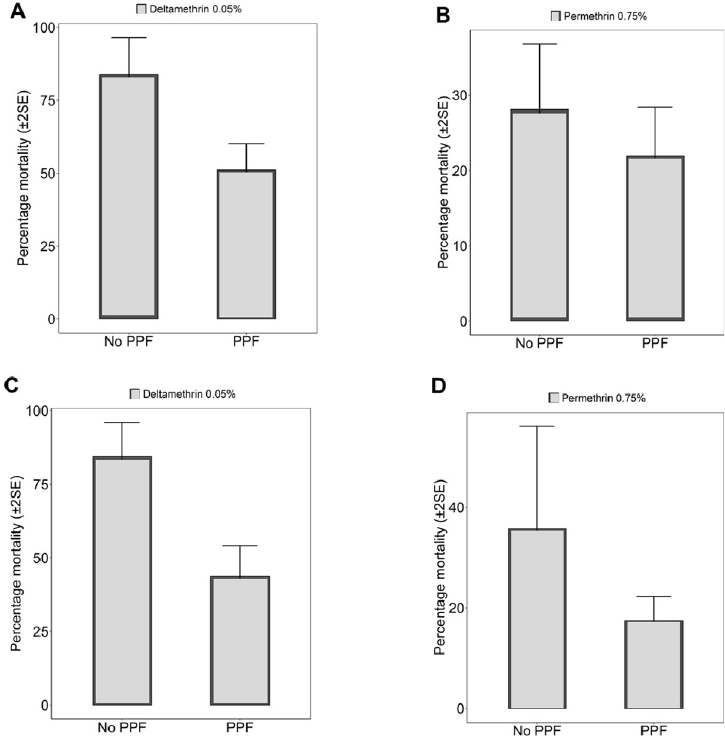
Fig 2. Pooled percentage mortality (24-hour) of: A & B. field resistant An . arabiensis mosquitoes, and C & D. resistant An . arabiensis colony reared through different doses of PPF (mg of active ingredient per litre, i.e. mgAI/L) and exposed to: 0.75% Permethrin, 0.05% Deltamethrin, using standard WHO susceptibility testing guidelines. Bars labelled “No PPF” represent percentage mortality of mosquitoes from the same colony, which were not treated with PPF but were exposed to the same insecticide at standard WHO-recommended dose.